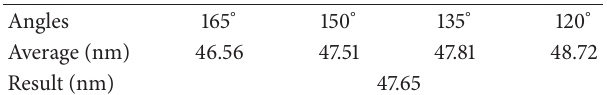
Table2:Measuredsizesof50 nmpolystyreneparticleversusvarious scattering